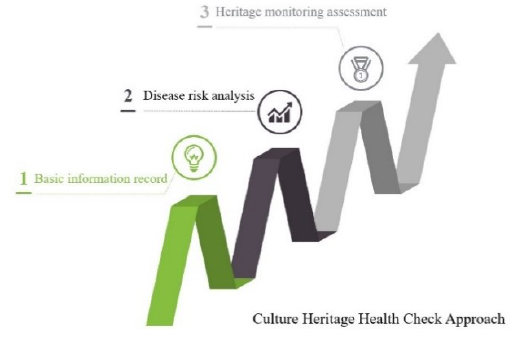
Figure 2: diagram of the three stages of cultural heritage health check